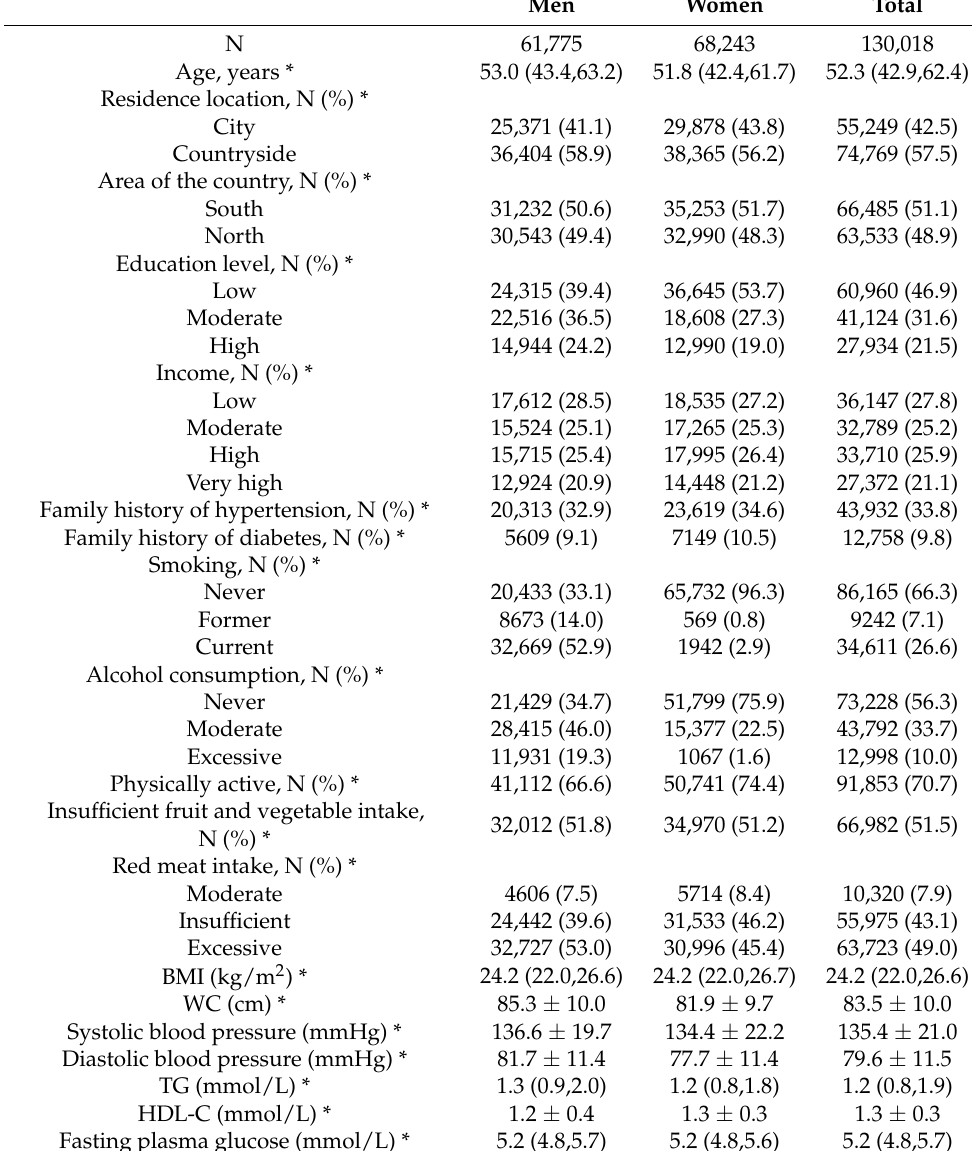
Table 1. Participant characteristics according to